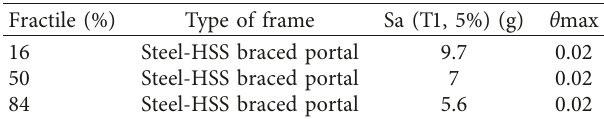
Table 10: Summarized capacity of the steel-HSS braced portal frame for immediate occupancy (IO) limit state.